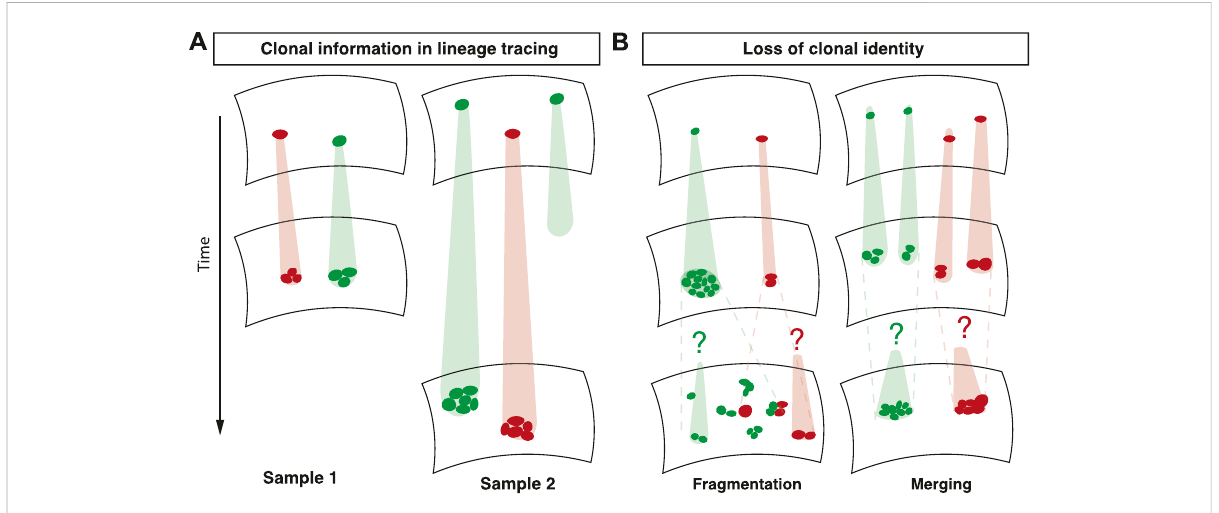
FIGURE 1 Overview of lineage tracing. (A) In lineage tracing experiments, a subset of cells is induced with an inheritable marker. The clonal relationship between an induced cell and its quanti fi ed progeny is used to unveil cell fate behavior. (B) Fragmentation and merging of clones renders the clonal identity of cells